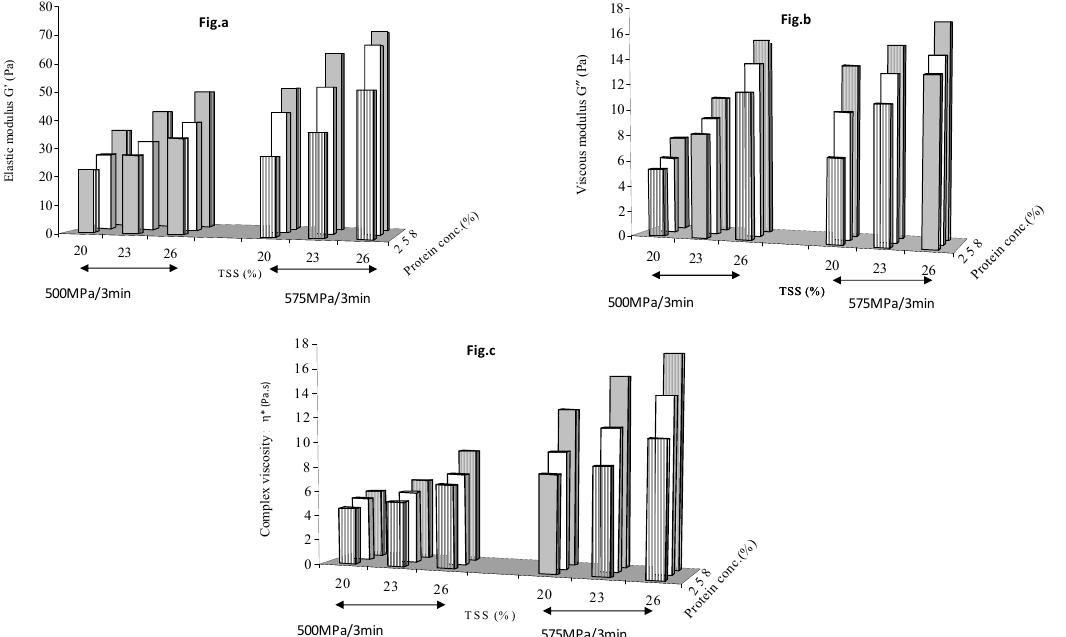
Figure 4. Effect of pressure (500 and 575 MPa) at 3 min holding time on ( a ) elastic modulus ( b ) viscous modulus and ( c ) complex viscosity.